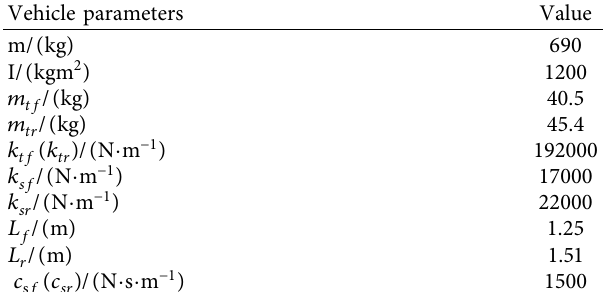
Table 1: Vehicle suspension model parameters. Vehicle parameters